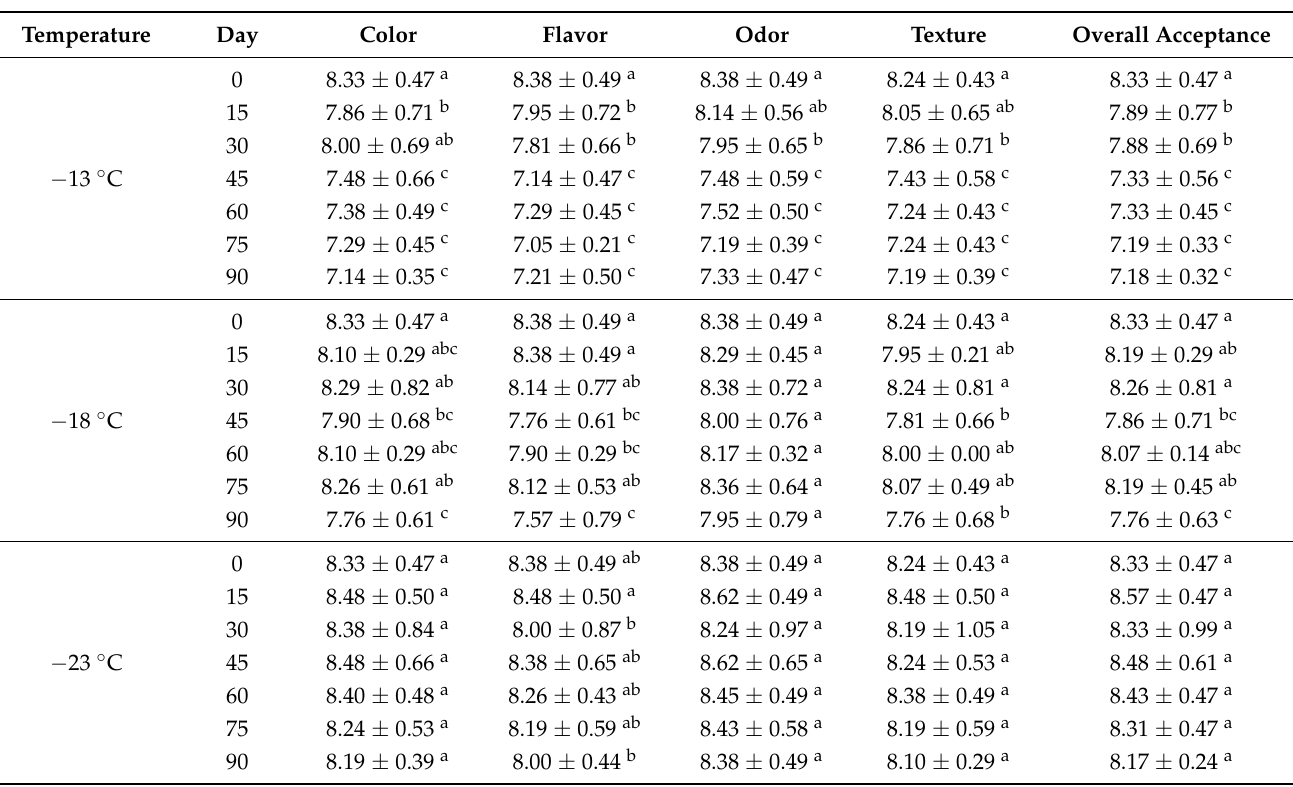
Table 11. Sensory evaluation of test seafood HMR products, consisting of a mixture of AMPS, CSM, and sauce, stored at different